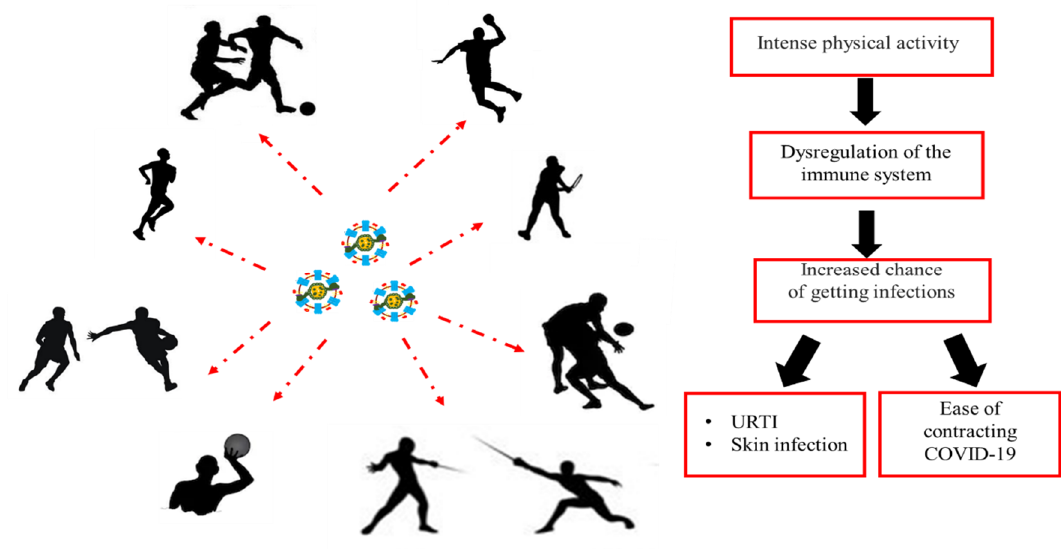
Figure 3. The immune system of athletes.